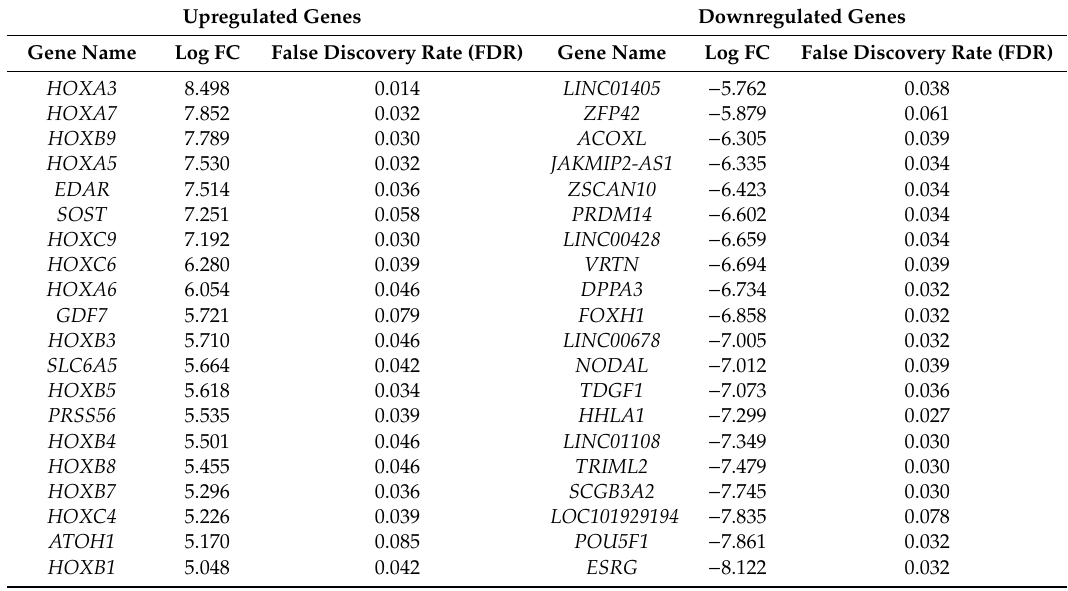
Table 1. RNA-seq of MPS1-H iPSCs derived neurospheres normalized on rescued